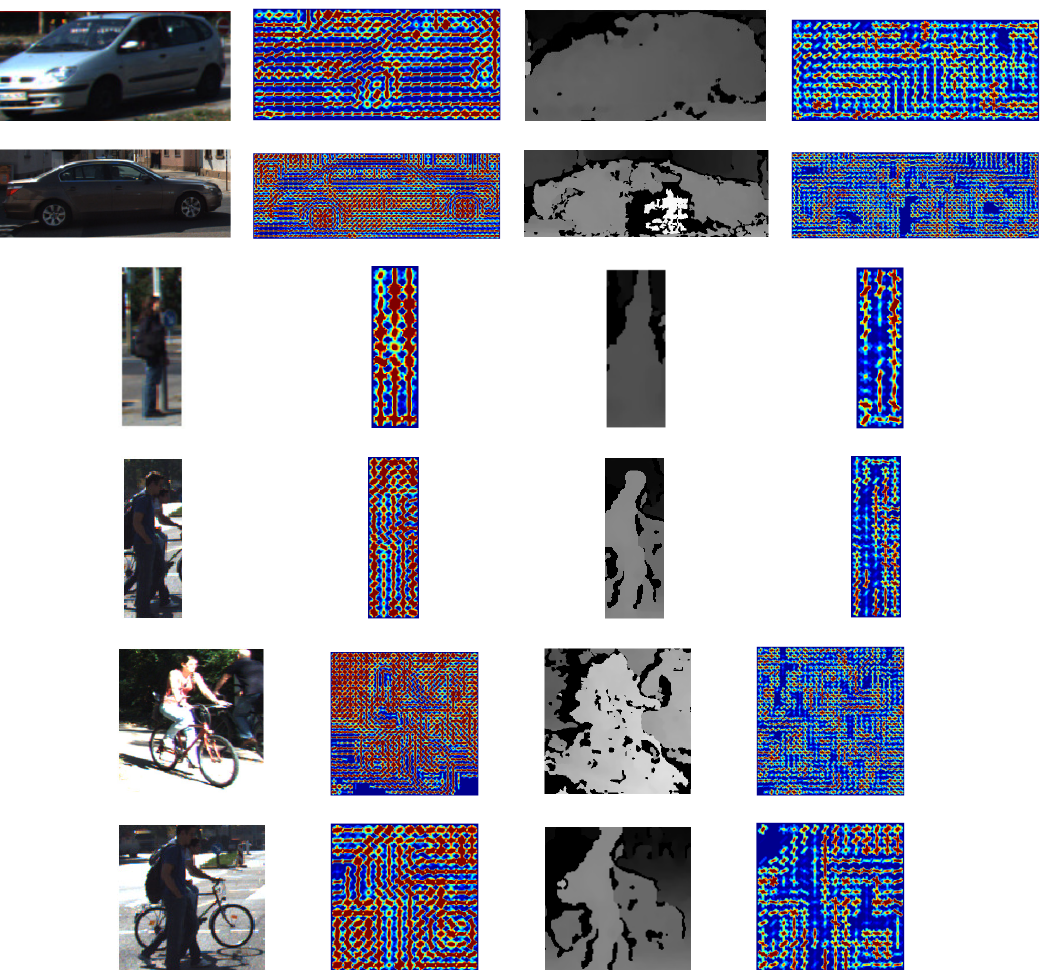
Figure 7. Object instances and their 3D-aware features, in particular C8B1 . These cars, pedestrians and cyclists have been detected on the test images using our trained models. In the figure, the first two columns display the original image and the color gradients; the next two columns show the disparity patch and its gradients. The gradient features are plotted as small glyphs of the positive weights of the descriptors on a color scale. Color gradients can be visually recognized more easily. However, disparity gradients provide complementary information about the objects’ depth, which leads to an enhanced description of